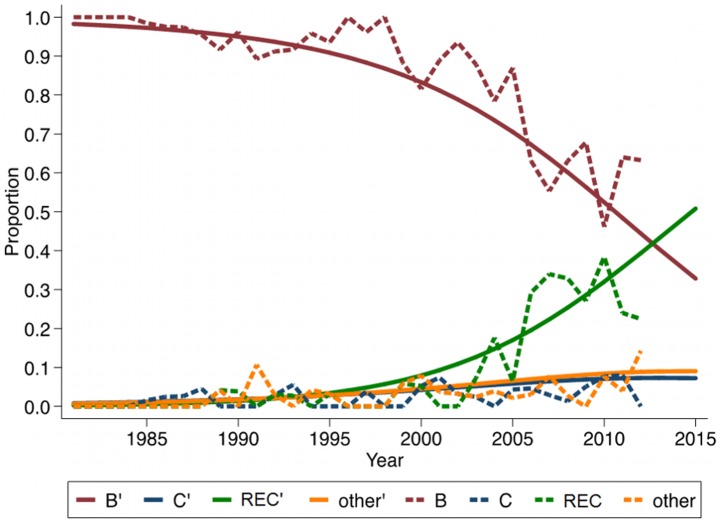
Proportions and predicted proportions of newly diagnosed HIV-1 subtype B (B), subtype C (C), recombinant forms (REC) and other subtypes (other) by year of diagnosis.Dotted lines represent actual prevalence in each year, while the smooth lines represent the predicted prevalence. Multinomial logistic regression model adjusted for year of diagnosis was used.